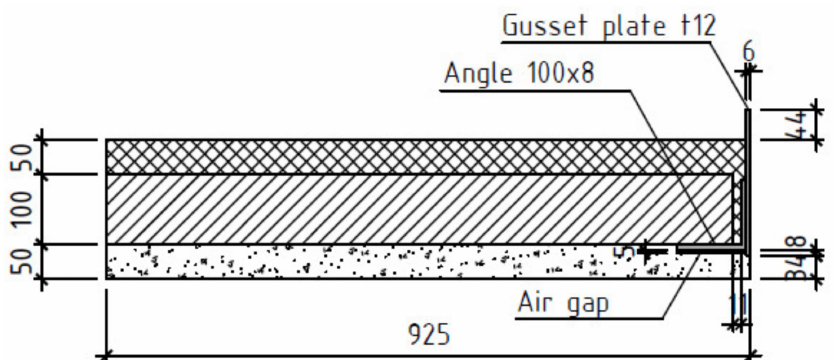
Figure 16. Calculation scheme with a gusset plate. Detachment of the finishing layer from the elements of the bottom chord of the truss (units: